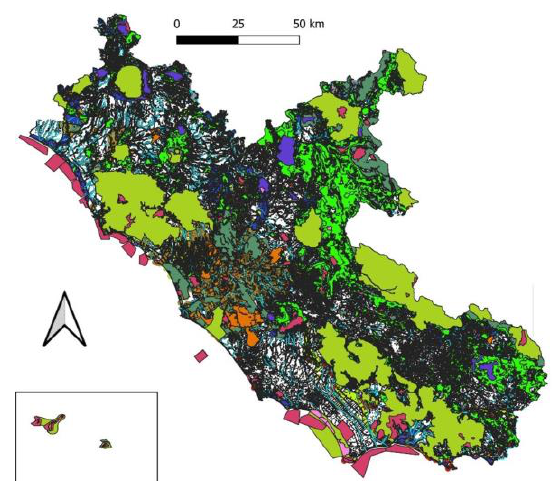
Figure 4 . Complete map of all constraints for large wind turbine plants; in white all not unsuitable areas.